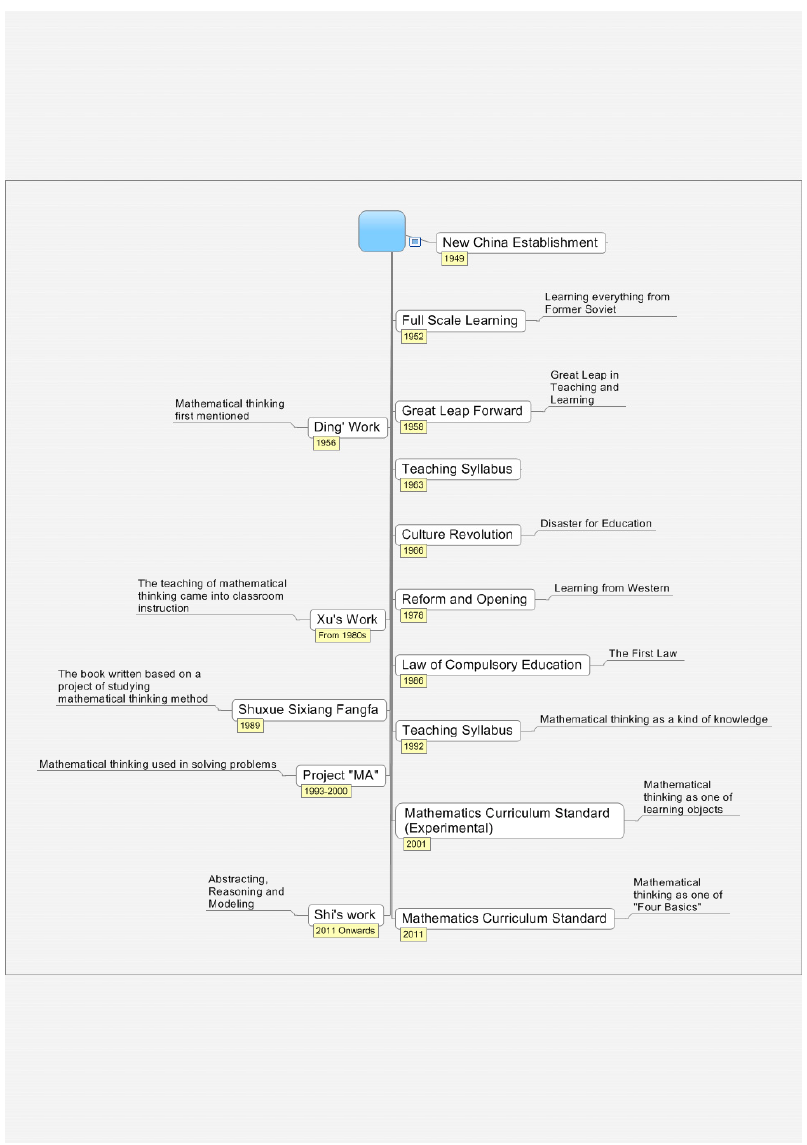
Figure 1. Overview of the evolution of mathematical thinking in Chinese mathematics education.